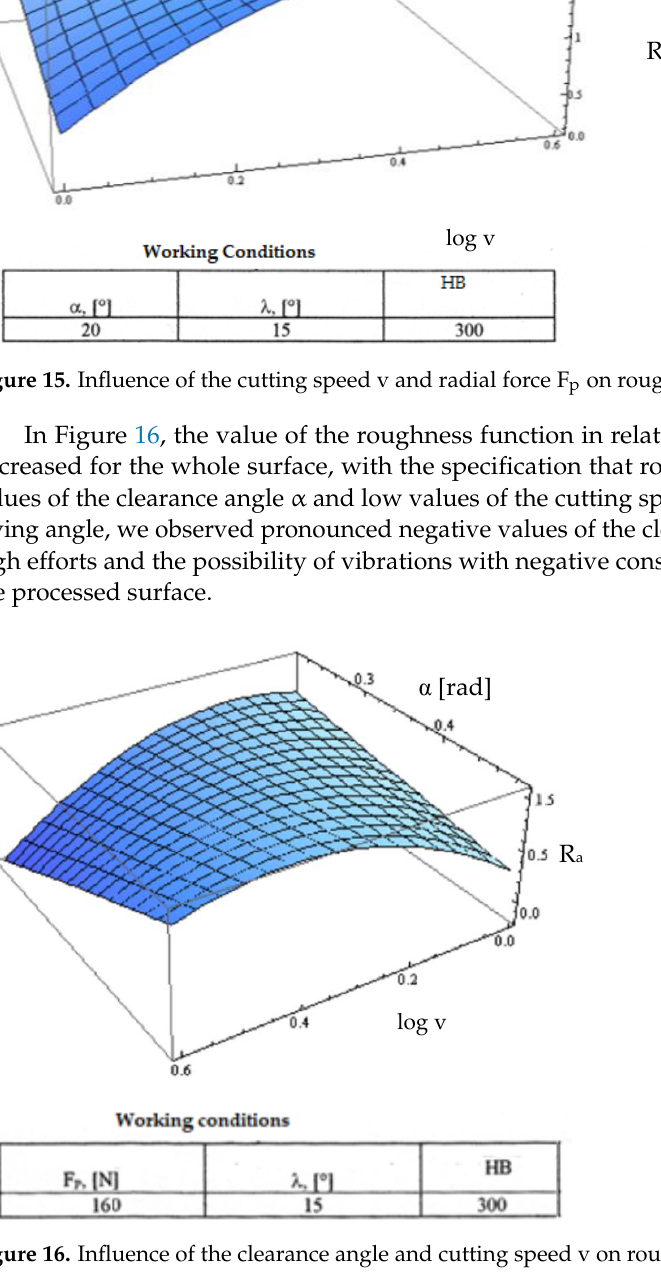
Figure 16. Influence of the clearance angle and cutting speed v on roughness R a.